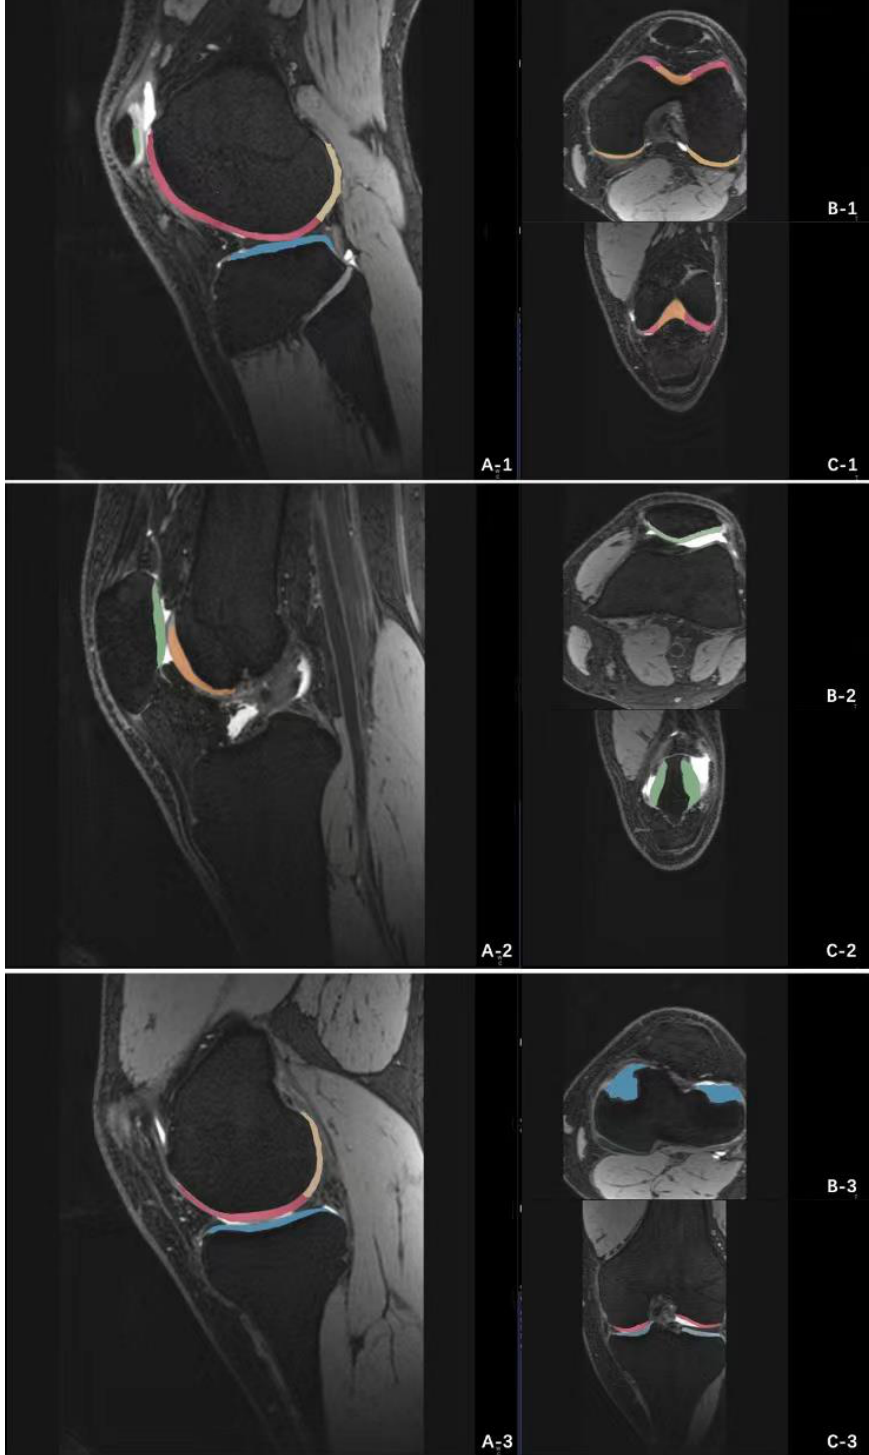
Figure 2. Siemens knee cap (version 1.5) software 3D-DESS image workstation operation interface. The software can automatically recognize and calculate the volume of each cartilage subregion of the knee joint. ( A-1 ), Sagittal position of lateral knee joint; ( B-1 ), Horizontal position of lateral knee joint; ( C-1 ), Coronal position of lateral knee joint; ( A-2 ), Sagittal position of middle knee joint; ( B-2 ), Horizontal position of middle knee joint; ( C-2 ), Coronal position of middle knee joint; ( A-3 ), Sagittal position of medial knee joint; ( B-3 ), Horizontal position of medial knee joint; ( C-3 ), Coronal position of medial knee